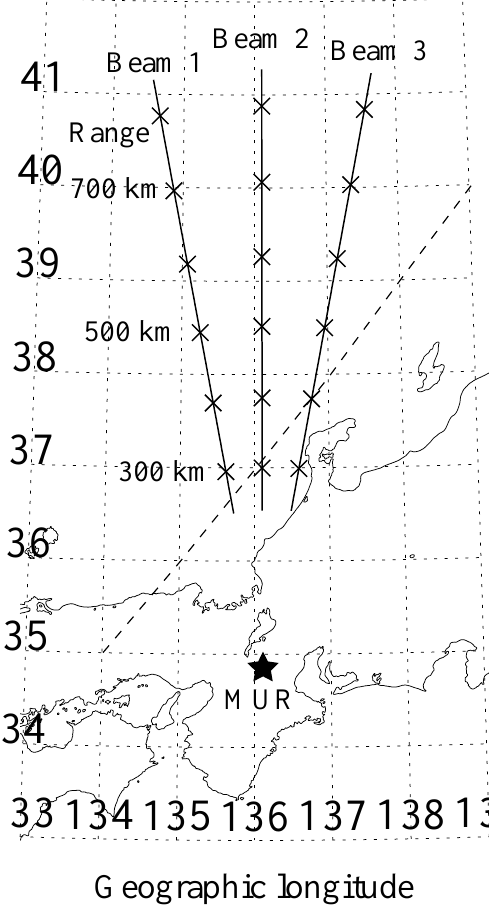
Fig. 2. Geometry of the observation. Three thick lines show the center of the radar beam with crosses marked at every 100km